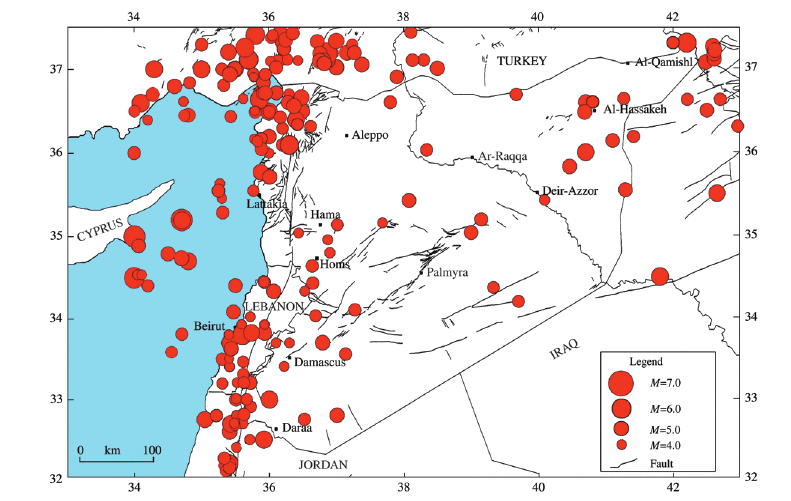
Fig. 2. Map of Syria showing the seismicity during 1900-1993 (Sbeinati,